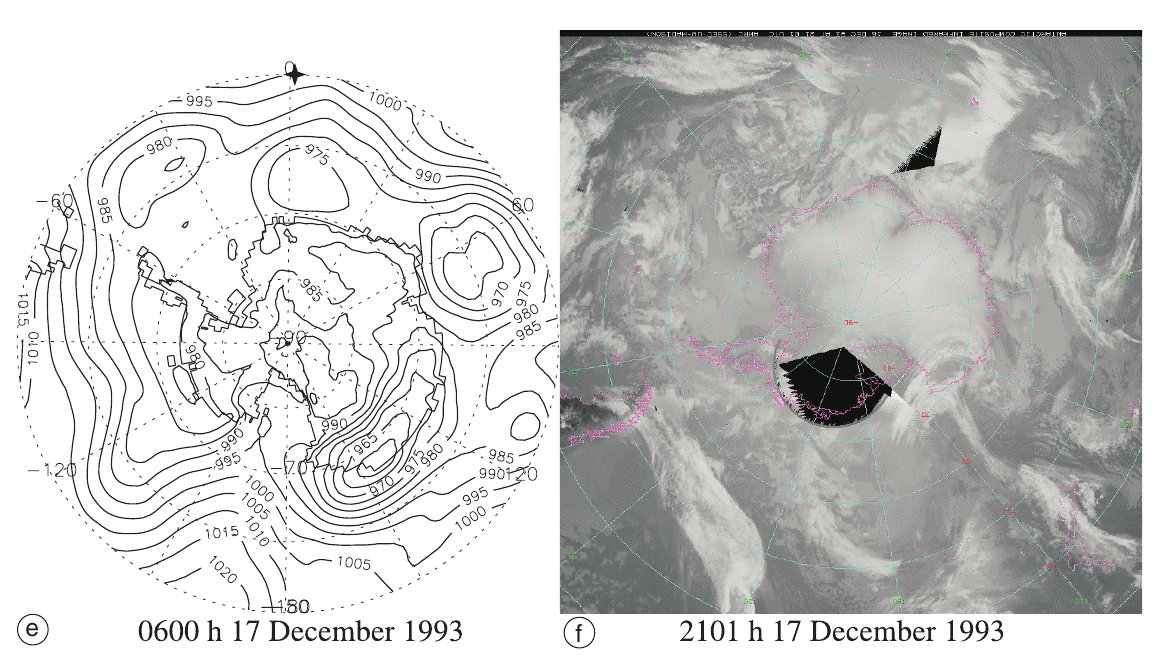
Fig. 11e,f. ECMWF analysis of mean sea level pressure chart and composite infrared satellite image for 0600 h 17 December